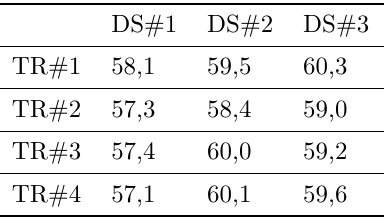
Table 2. Results for DS: HMPE#1.